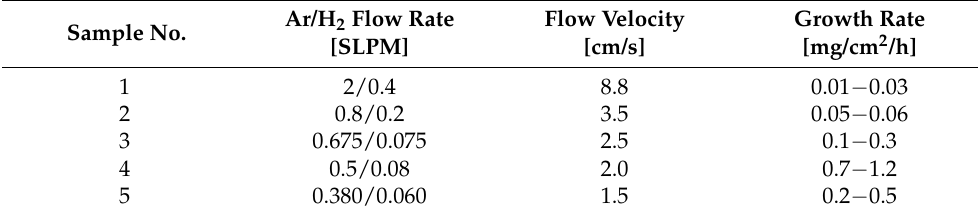
Table 2. Results for different flow